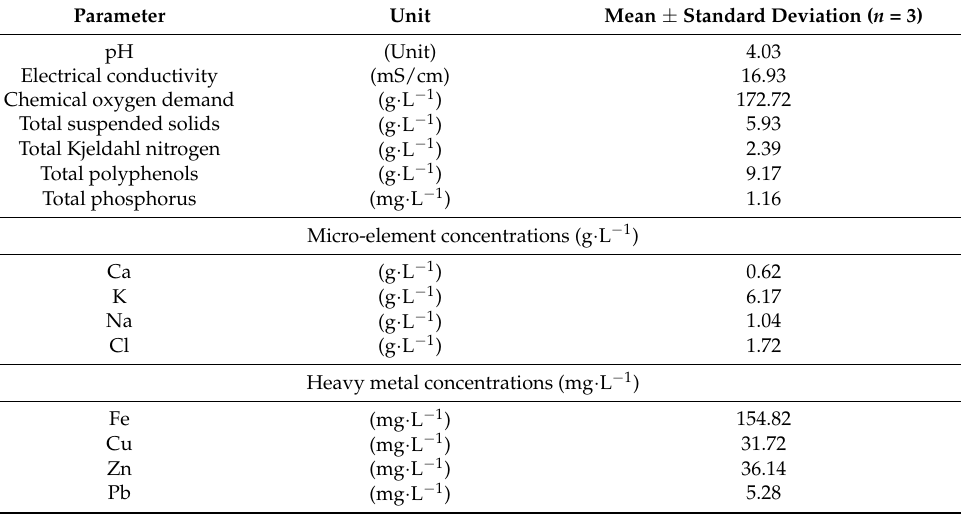
Table 3. Physico-chemical characteristics of the raw